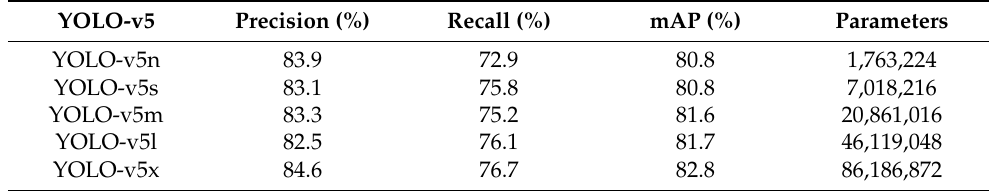
Table 3. Performance comparison of network structures of different widths and depths.